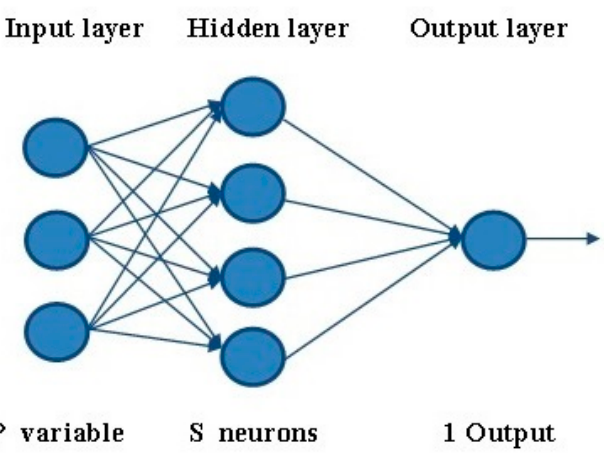
Figure 2. Topology of conventional P − S − 1 MLP.